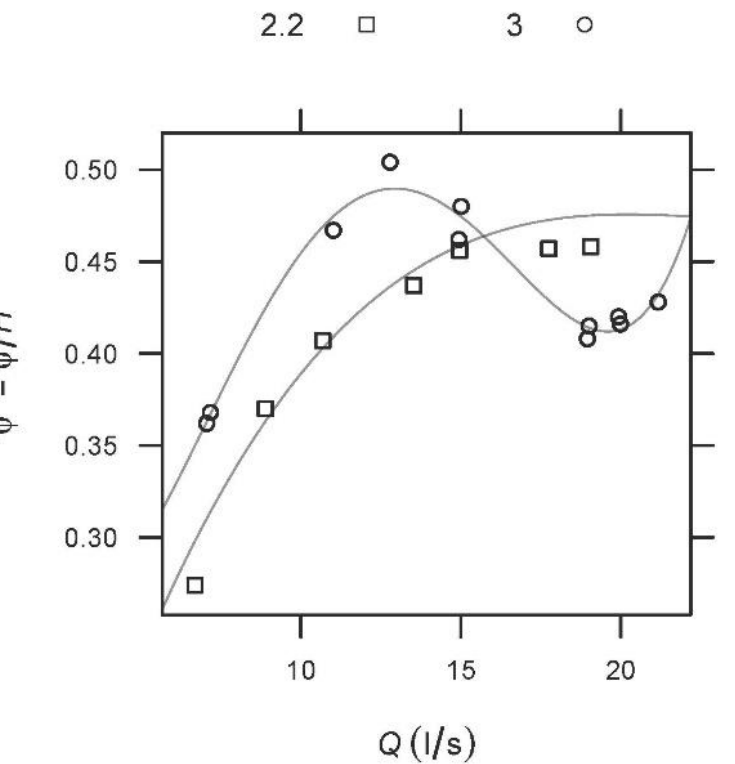
Figure 11. Hydraulic pressures measured in a single section of the physical models located at x ∗ = 0.3 (30% of the base length from the crest) in tests n o 87 [ Z dss = 2.2] and n o 94 and 95 [ Z dss = 3.0]. The plotted pressures for Z dss = 3.0 were averaged between both tests (Figure 8).